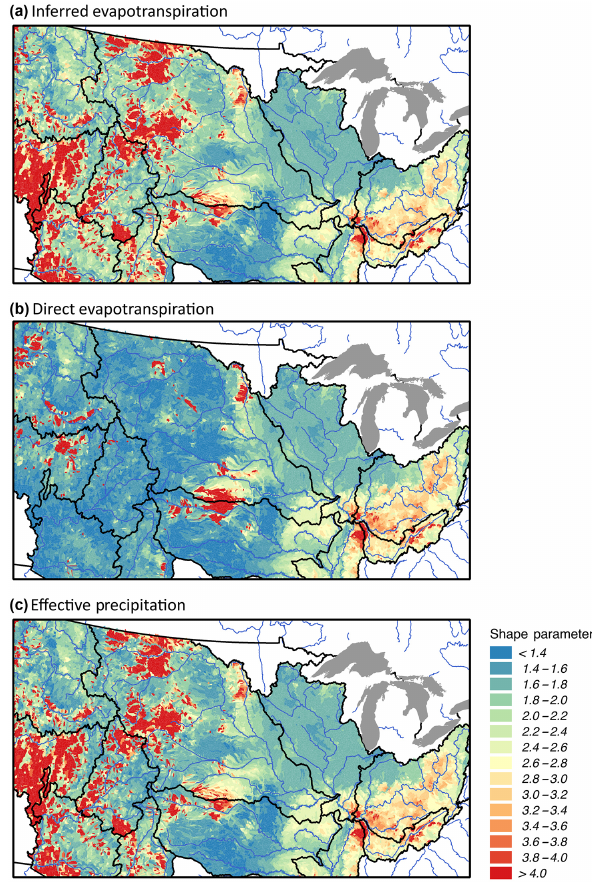
Figure 9. Map of shape parameters calculated for the 24235 nested watersheds using the (a) inferred evapotranspiration, (b) direct evapotranspiration and (c) effective precipitation. Major rivers are outlined in blue and regional boundaries in